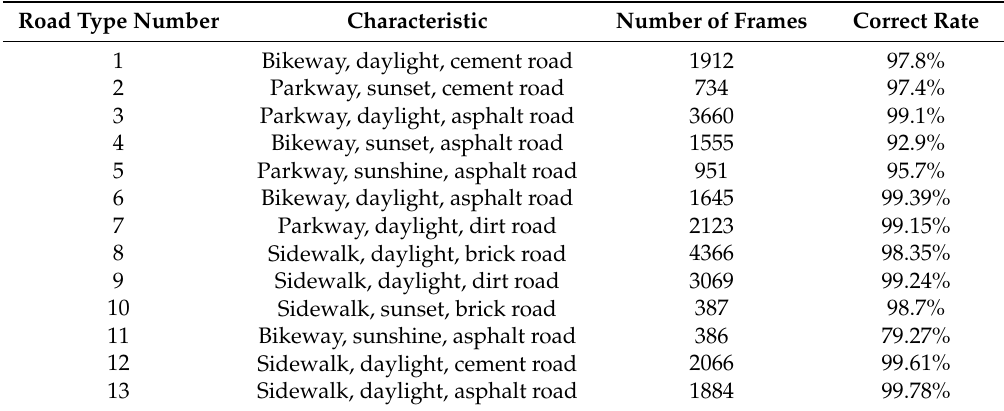
Table 2. The correct